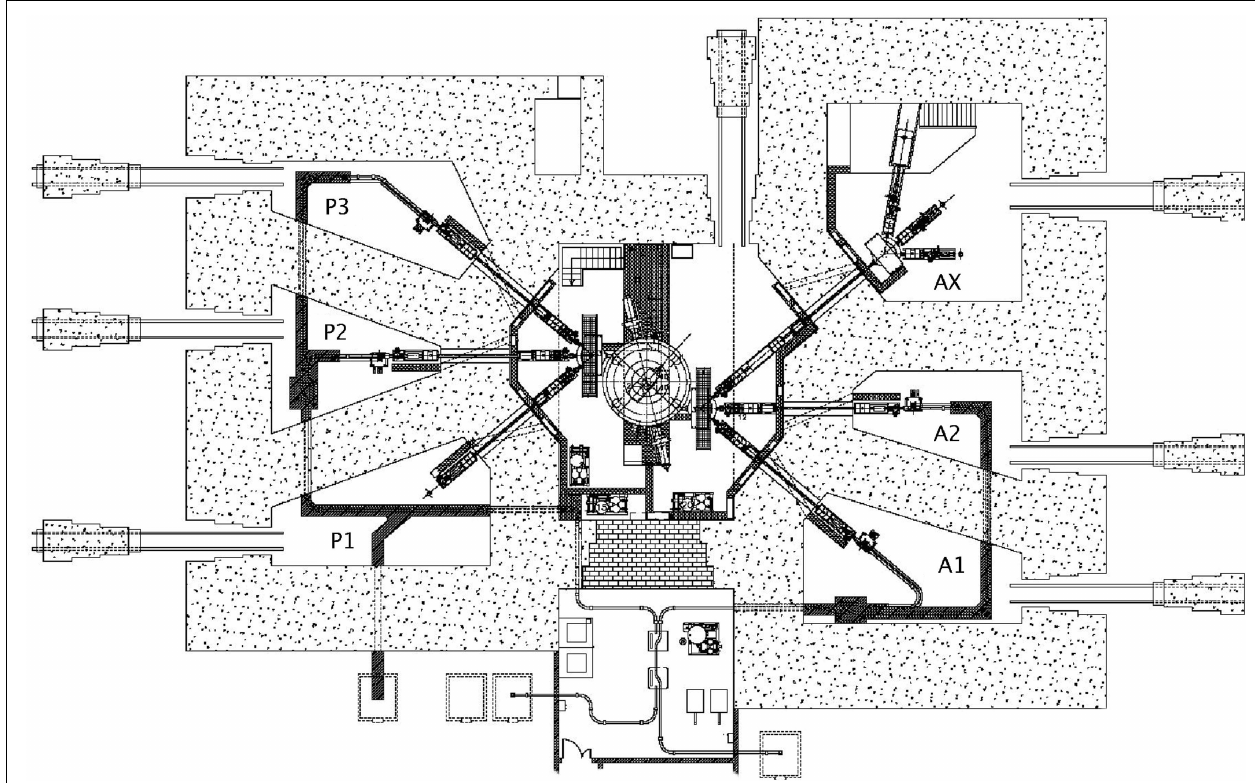
new generation of cameras based on a liquid xenon time projec- tion chamber, a spatial resolution of 2.3 mm has been estimated with an injected activity of 0.5 MBq for a Sc-44g point source emitter ( 7).